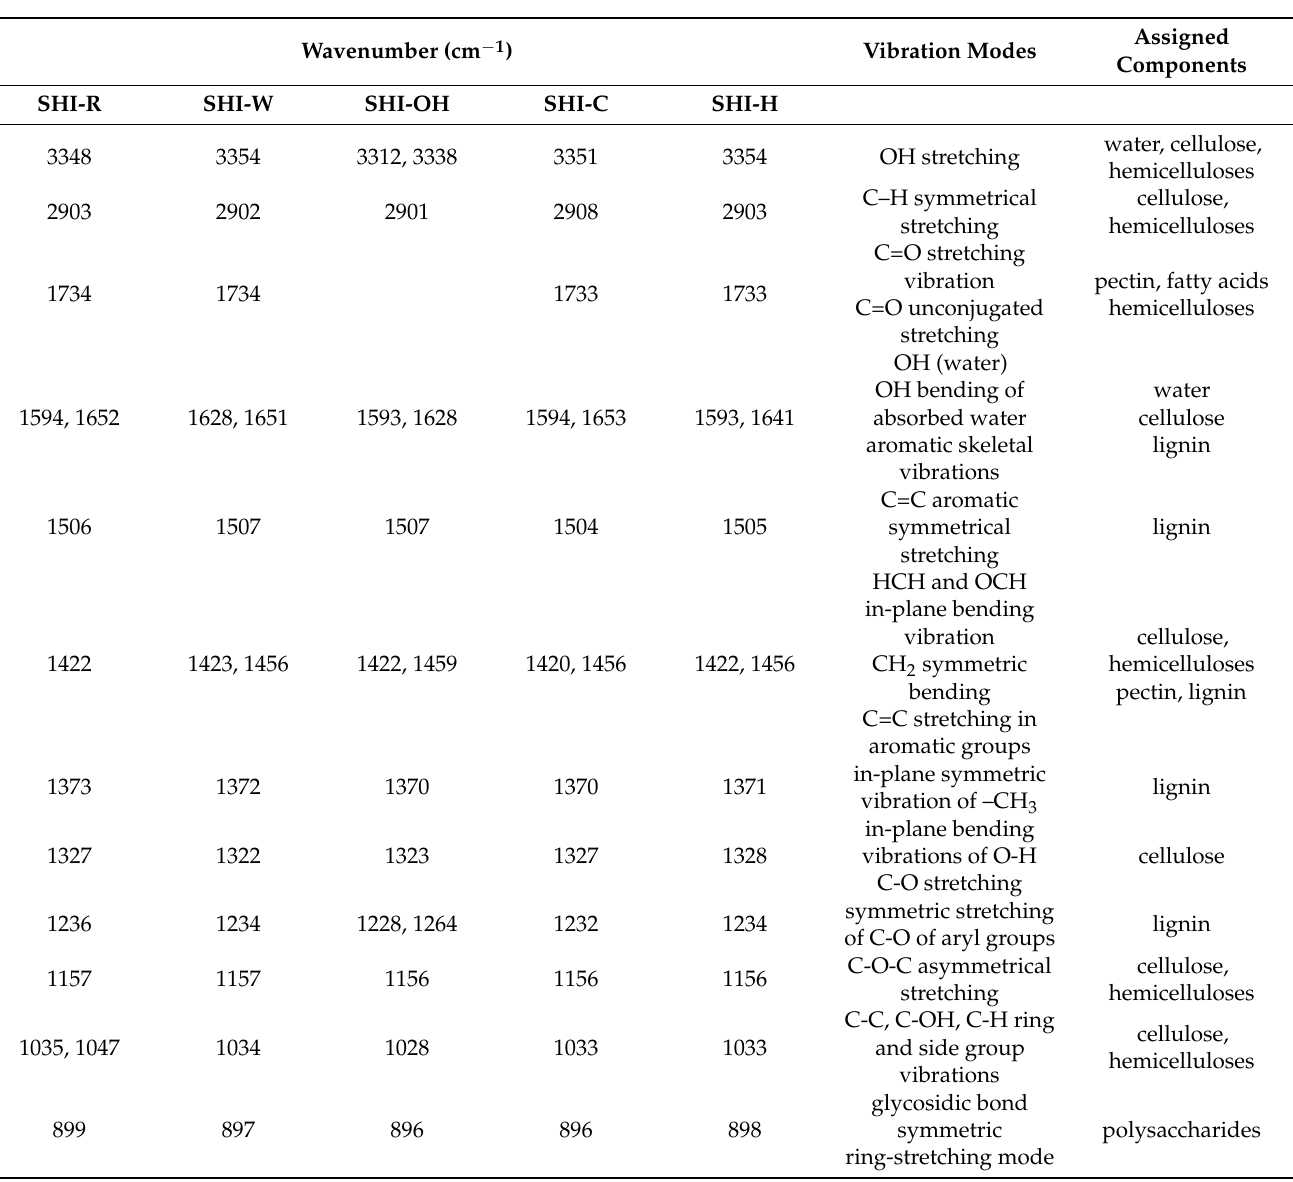
Table 2. The main absorption bands in each ATR-FTIR spectrum of hemp shive samples in powder form and their assignment to chemical group vibrations and components.